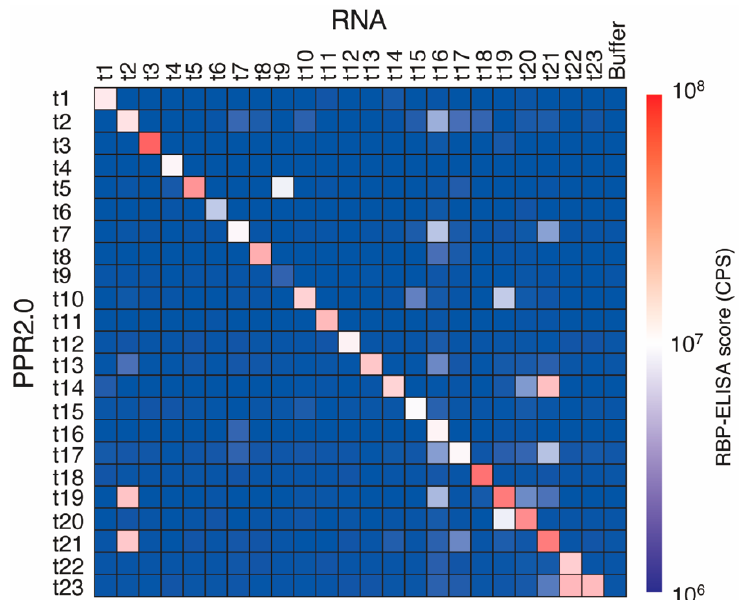
Figure 3. Evaluation of the versatility of the designer PPR proteins of the PPR2.0 scaffold. Heatmap of the binding signals of the designer PPR proteins. RBP-ELISA was used to perform all combinations (288 reactions) using 23 designer PPR proteins (t1 to t23) and their target RNAs, with no RNA (buffer) as a background signal.